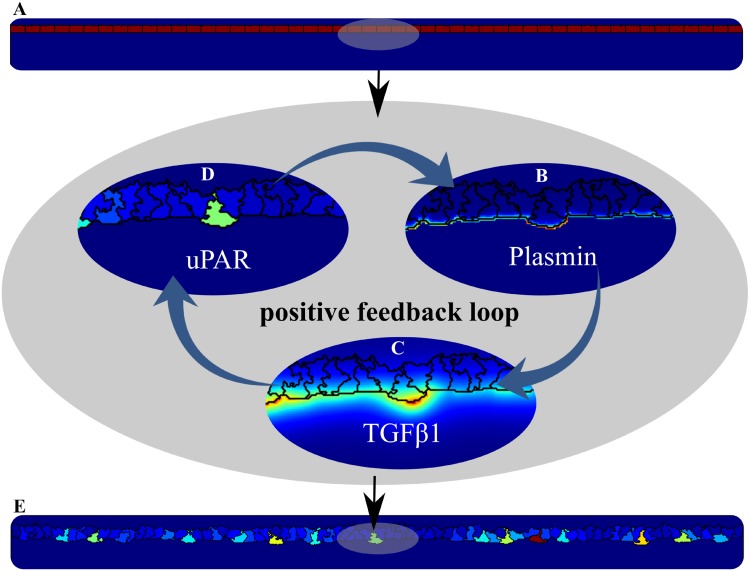
Spontaneous ‘uPAR-rich’ cell selection in the monolayer by a uPAR-plasmin-TGFβ1 positive feedback loop.All cells in the model (A) express the same level of uPAR (the uPAR concentration in the cells is indicated by the red color) at initialization of a simulation. Local changes in fibrin-cell contact can increase local plasmin concentration (B), resulting in degradation of fibrin and release of active TGFβ1 (C). TGFβ1 can stimulate uPAR expression (D). The positive feedback loop selects ‘uPAR-rich’ cells in the monolayer (E), with a few cells having high level (red color) and most cells having low levels (blue color).